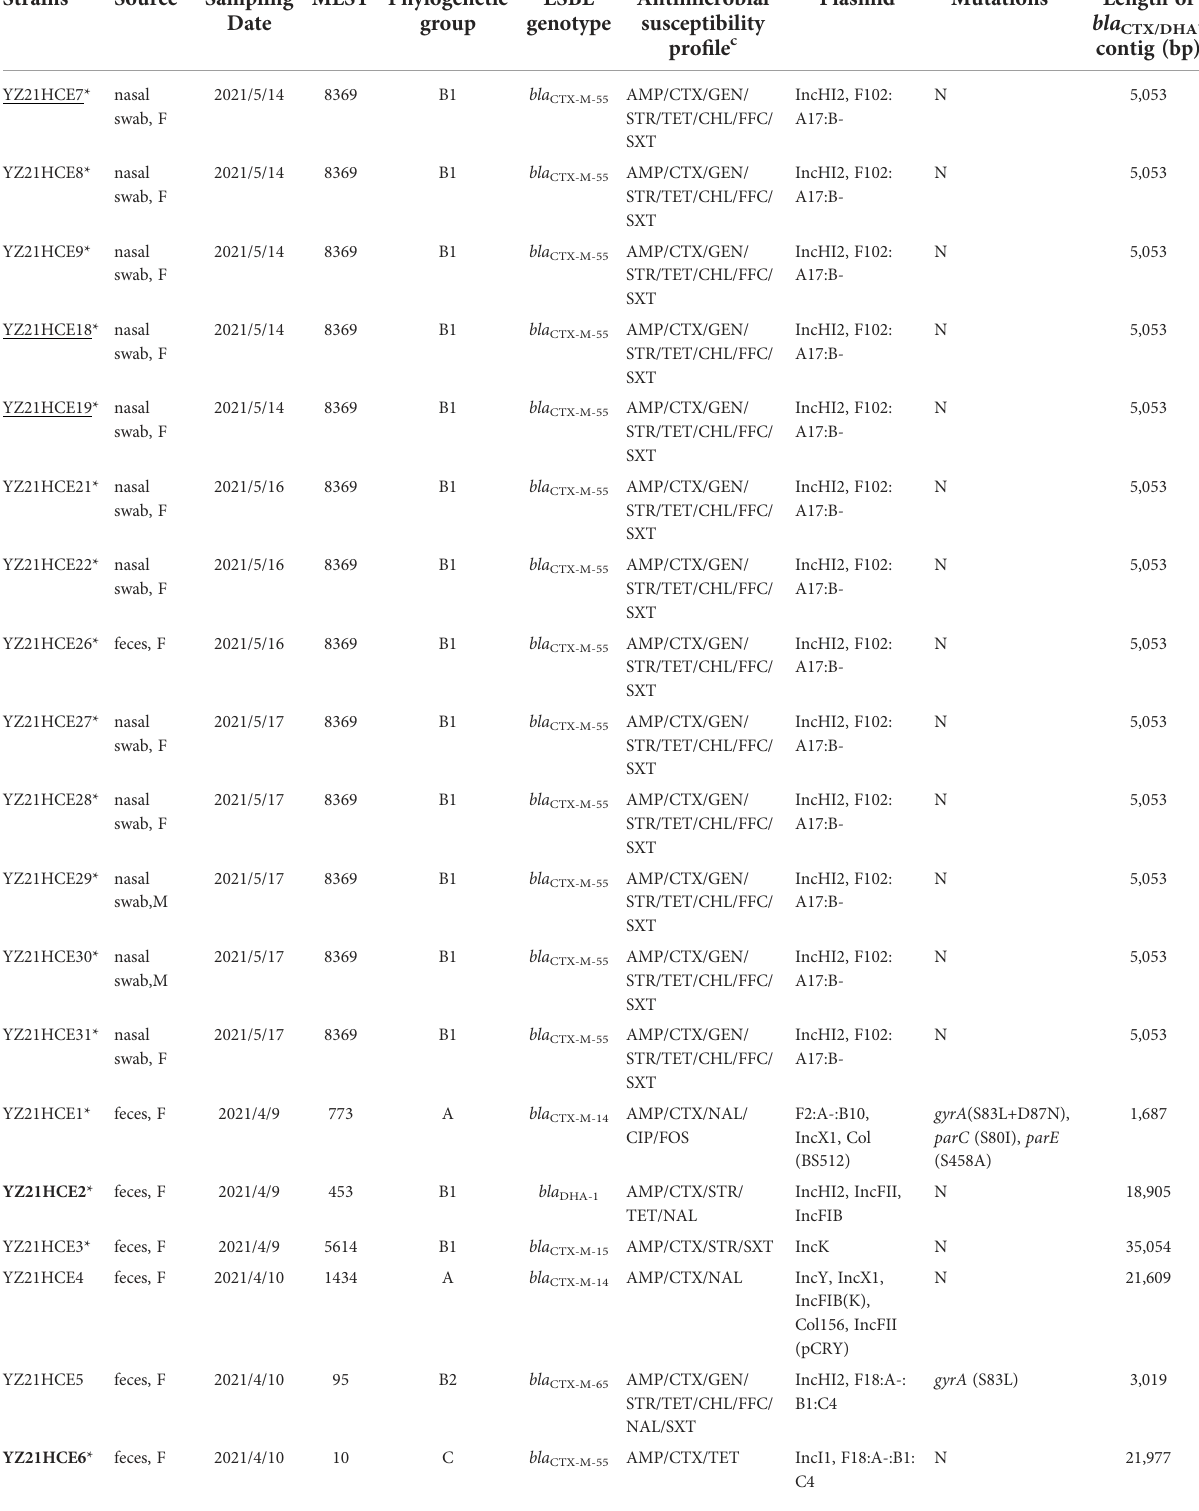
TABLE 1 Chracterization of cefotaxime-resistant Escherichia coli isolates in this study. Strains